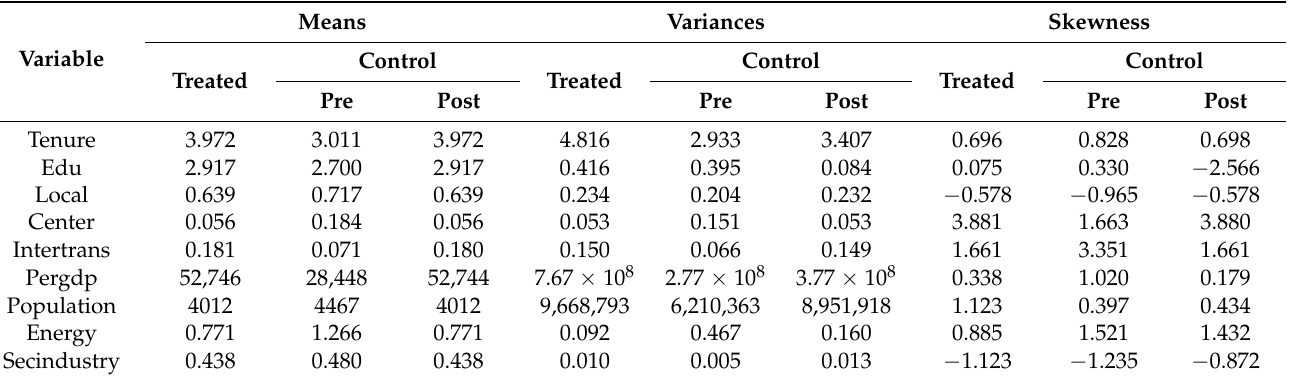
Table 8. Results of covariate